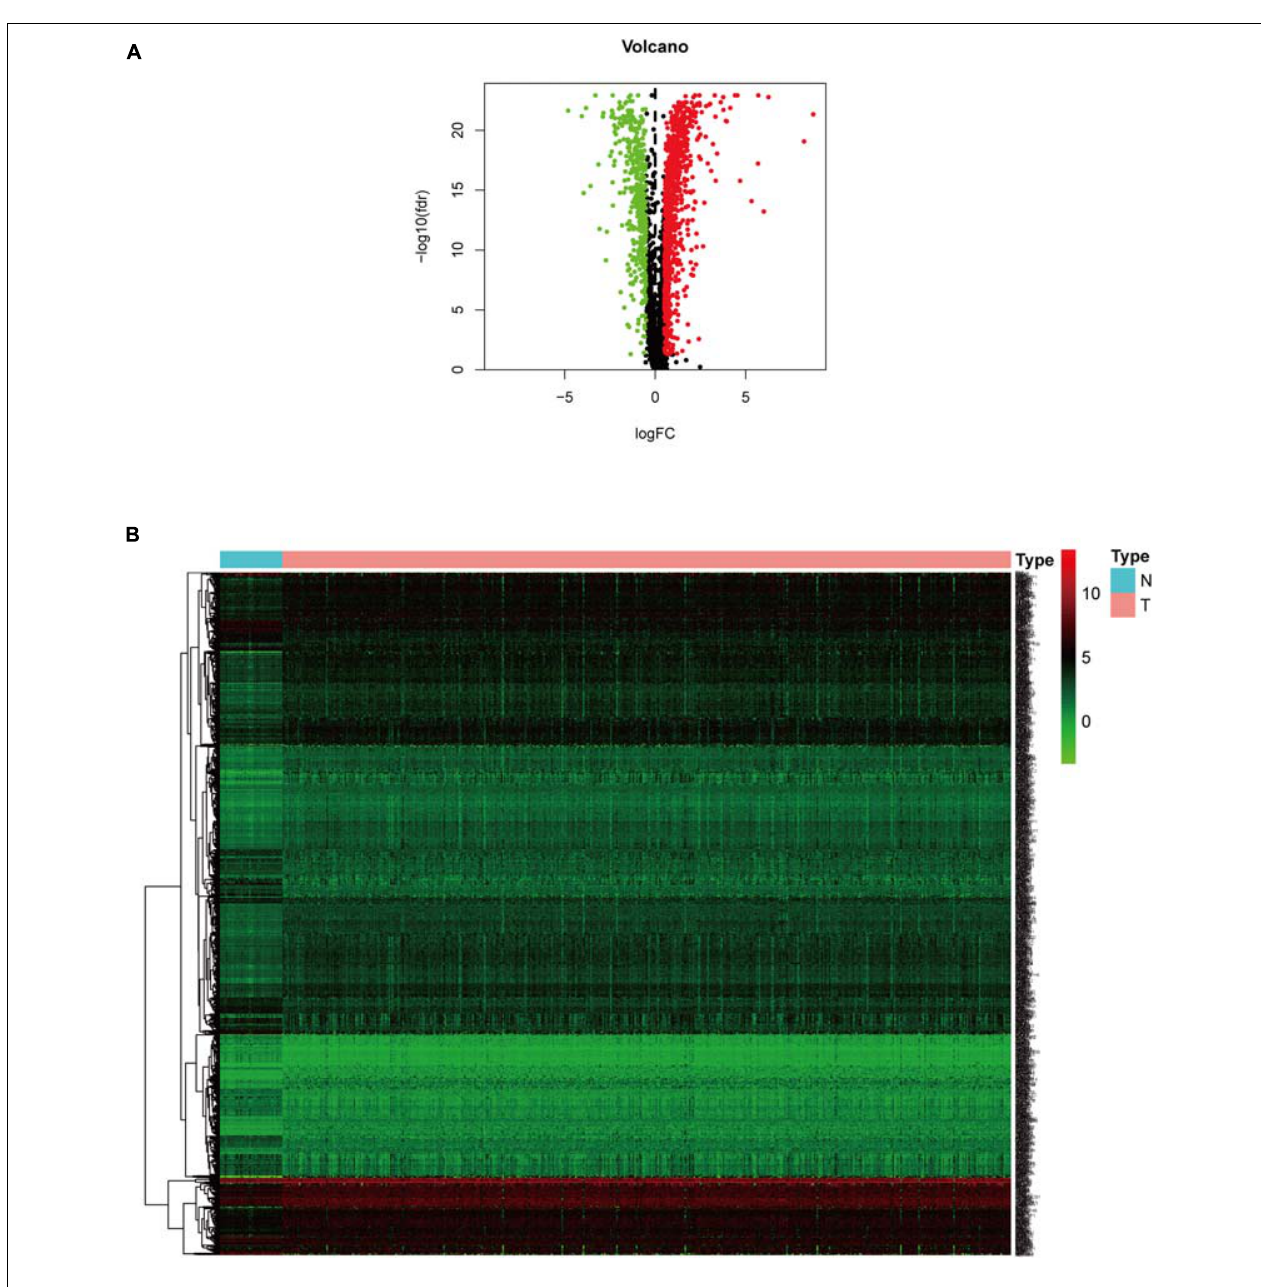
FIGURE 2 | Expression analysis of differential hypoxia genes. (A) Volcano plot. Green dots and red dots represent down-regulated and up-regulated genes in COAD samples, respectively. (B) Heat map. Green and red correspond to genes with low and high expression levels,